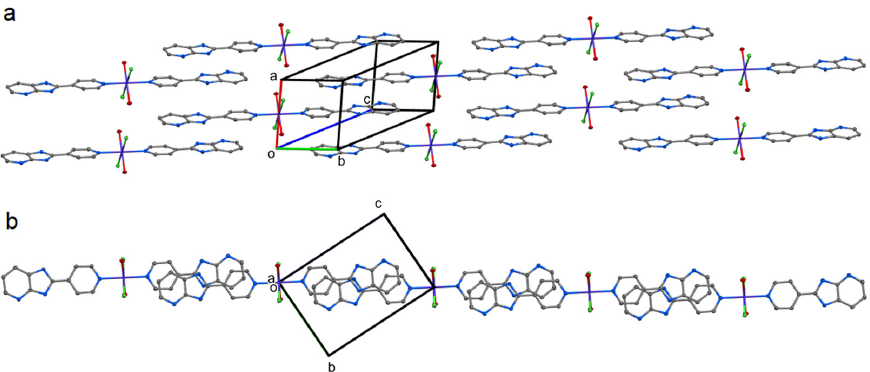
Figure 5. Molecular structure of C1 .